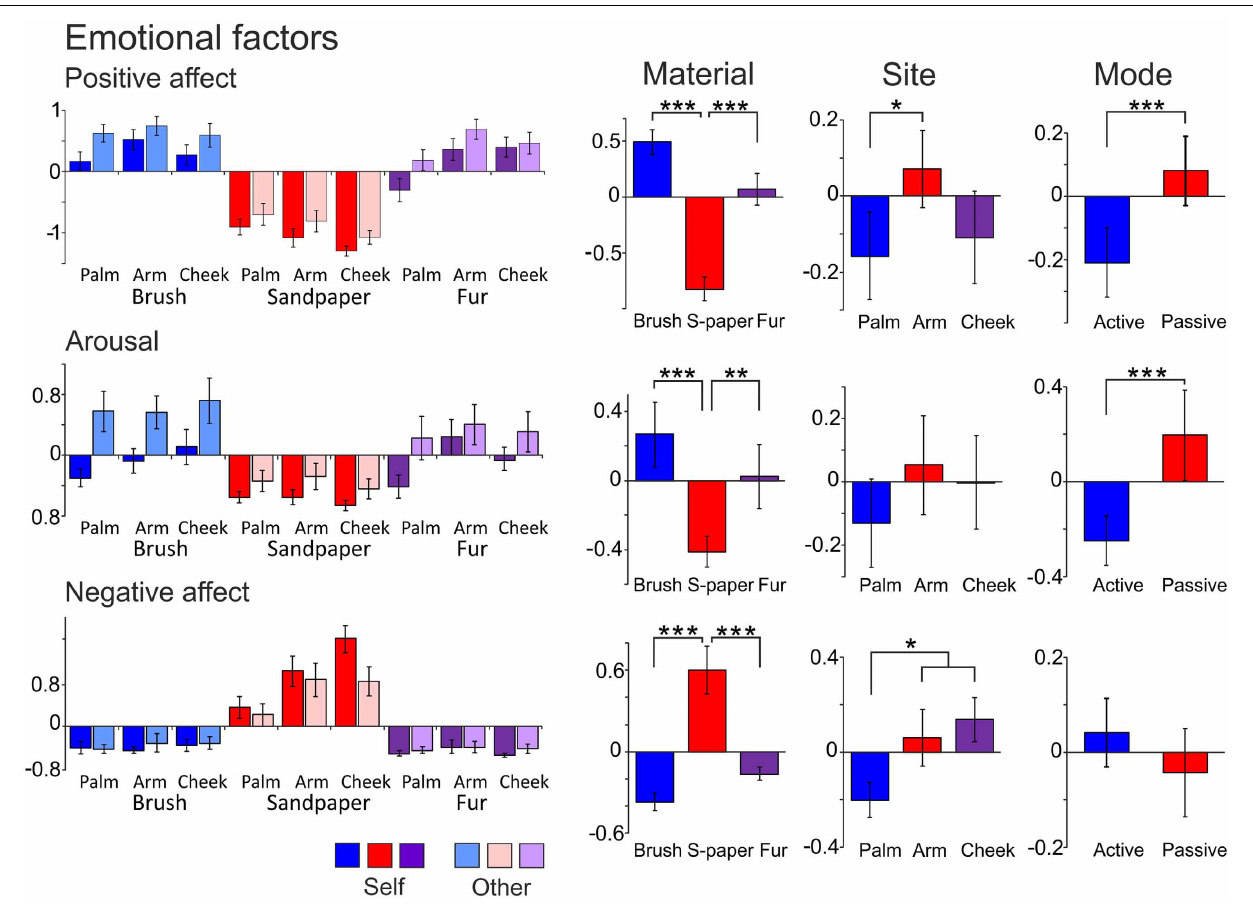
FIGURE 2 | The average scores for the emotional factors. Each factor (Positive Affect, Arousal, and Negative Affect) is displayed with the average scores for the levels of each condition (far left graphs), then the average for the Material, Site and Mode conditions. Significant differences between the levels